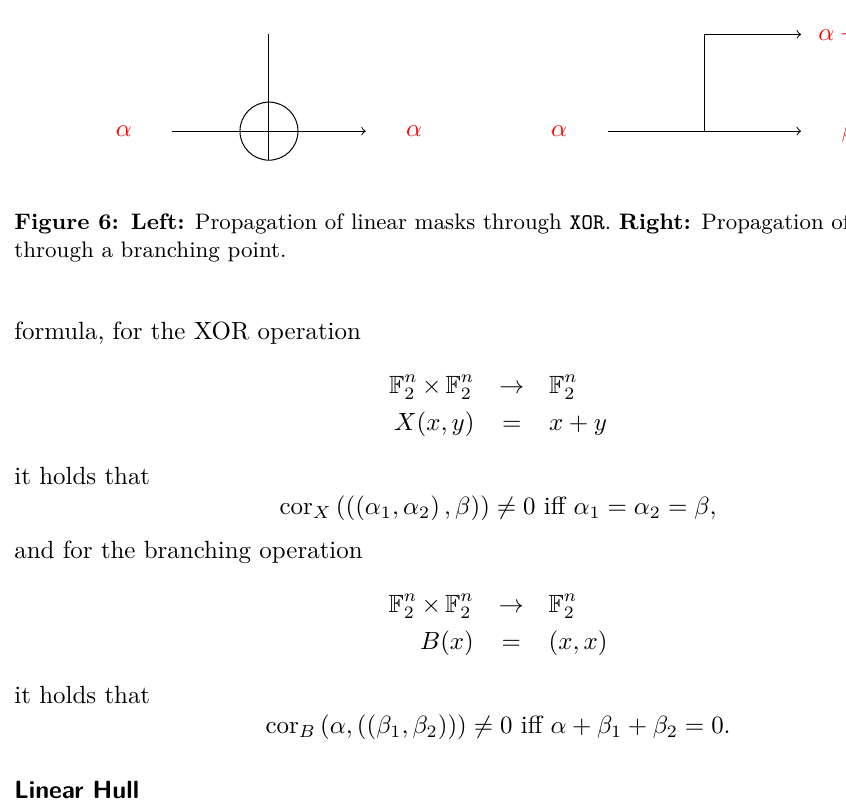
Figure 5: Differential model.